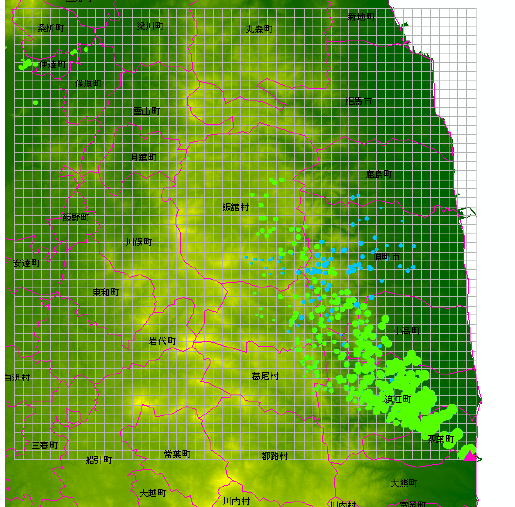
Figure 8. Particle trajectory estimated from wind directions and velocities on March 15.